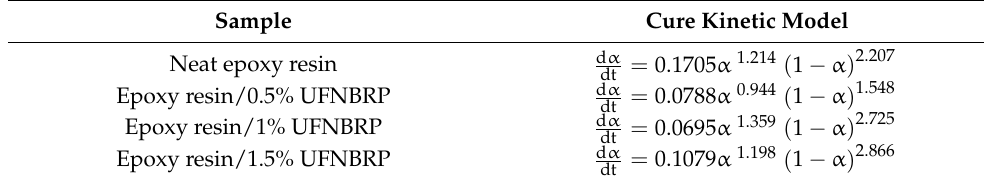
Table 4. The predictive curing kinetics of Sestak-Berggren autocatalytic model. Sample Cure Kinetic